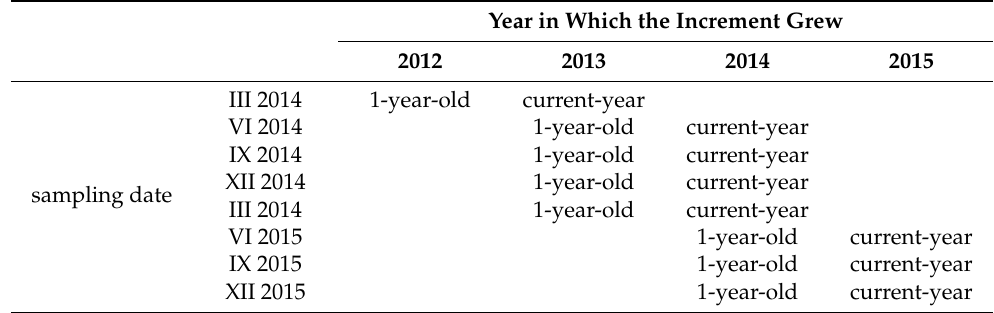
Table 1. The scheme of sampling of Taxus baccata shoots during 2-year bud-removal experiment and the division of increments on current and 1-year-old shoots at each sampling date. Year in Which the Increment